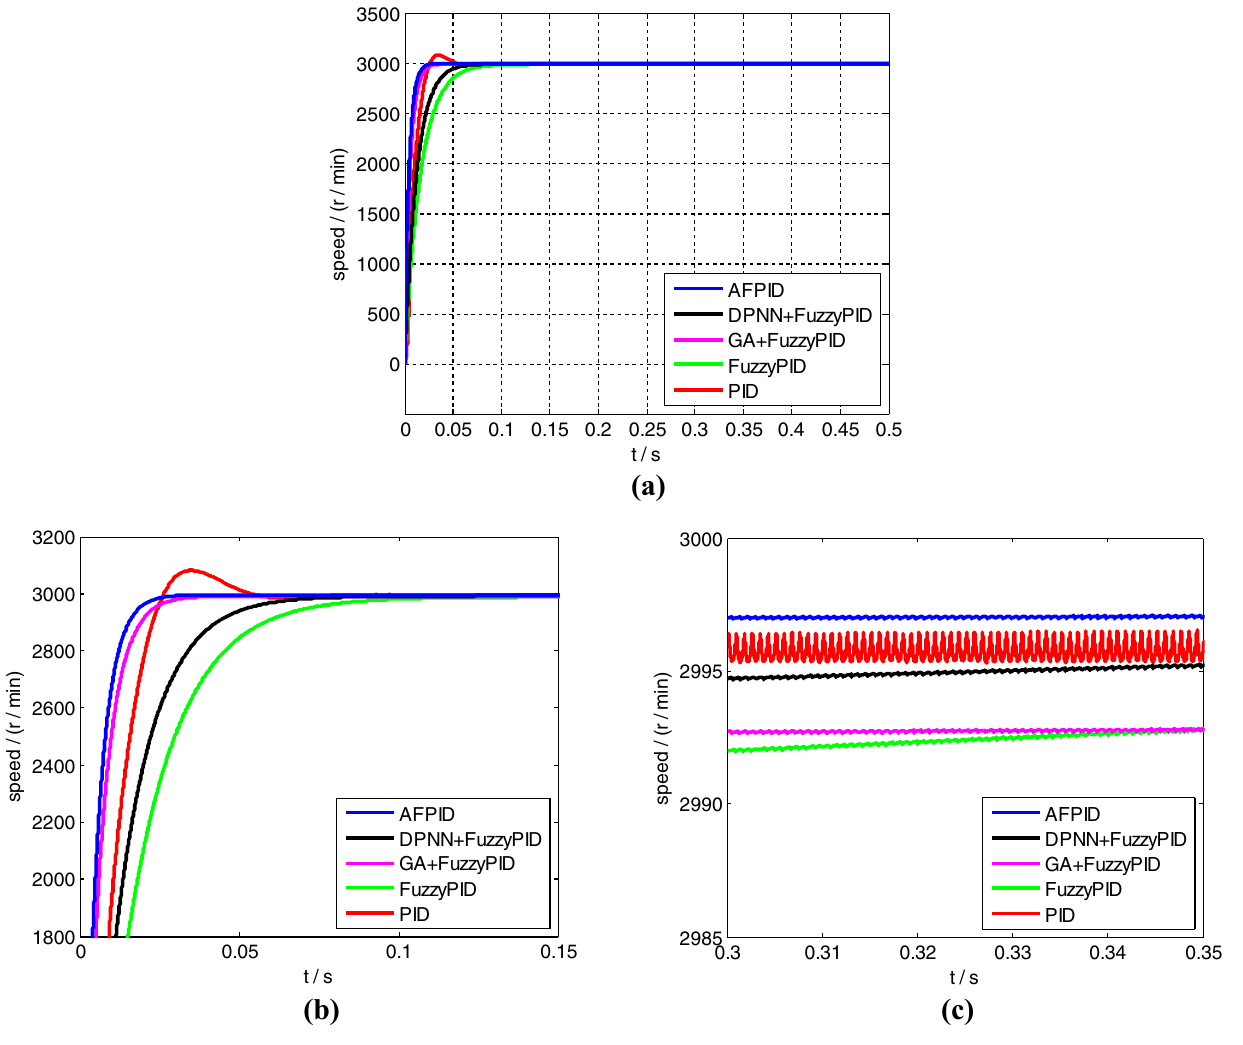
Fig. 9 The comparison of speed variation with sinusoidal load disturbance: a speed response curve of 0–0.5 s, b transient speed response curve of 0–0.2 s, c transient speed response curve of 0.3–0.35